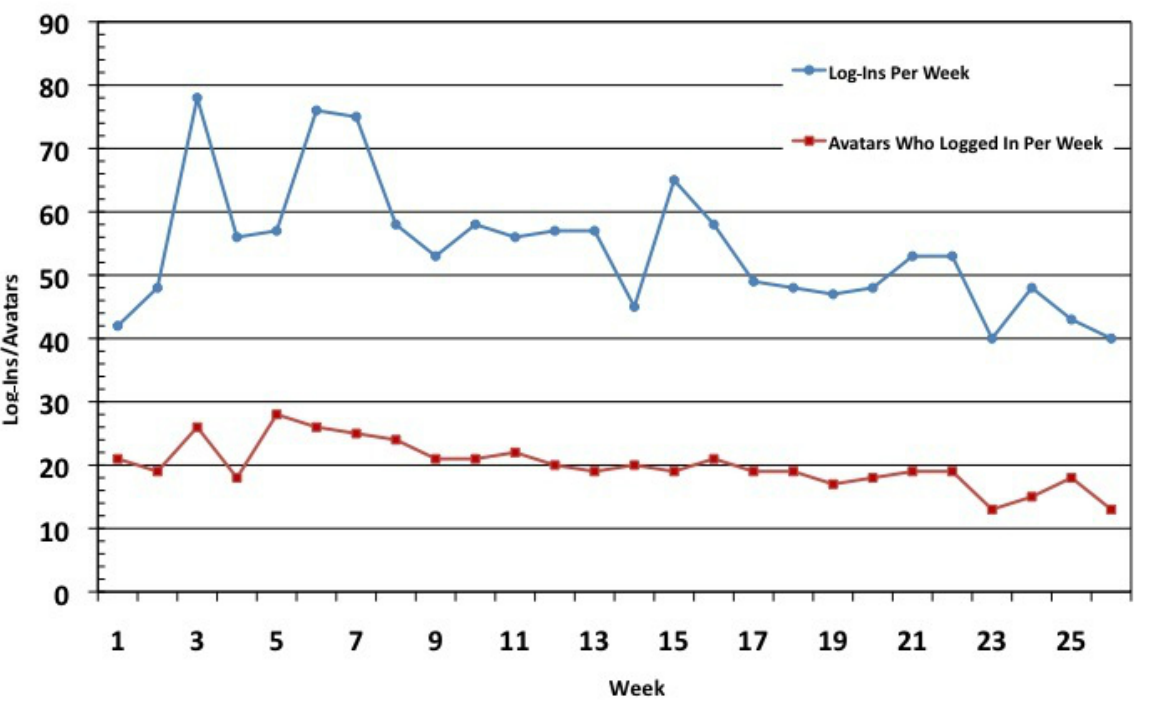
Figure 2. Total weekly log-ins and total avatars that logged in each